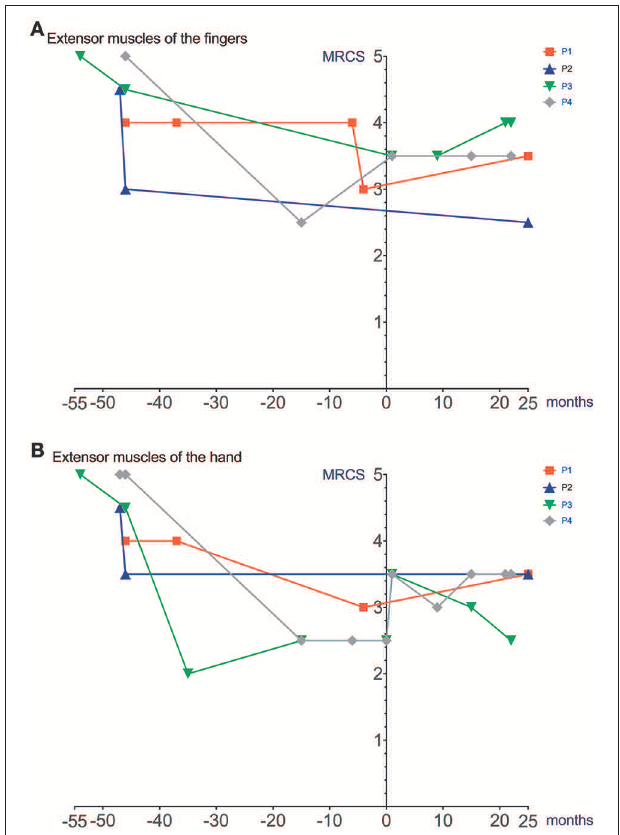
FIGURE 3 | Manual muscle strength prior to and after initiation of Ataluren treatment. Graphic representation of extensor muscles of the fingers (MRCS) (A) and extensor muscles of the hand (MRCS) (B) in relation to time. Time point 0 represents start of Ataluren treatment in all figures (P1 and P2 13th October 2015; P3 and P4 5th February 2016). Age at start of Ataluren: P1 and P2 14 10/12 years; P3 14 9/12 years; P4 11 11/12 years). Note that time period’s alternate because of a lack of data in some values. MRCS, Medical Research Council Scale.